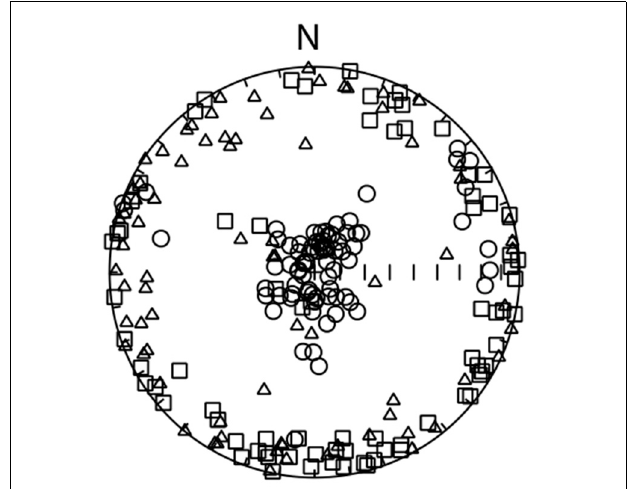
FIGURE 6 | Equal area net showing Moenave Formation high field anisotropy results in stratigraphic coordinates. Open circles are minimum axes, squares are maximum axes, and triangles are intermediate axes, all points lower hemisphere. Minimum axes are perpendicular to bedding, with maximum (and intermediate) axes lying in the bedding plane indicating a bedding parallel fabric typical of deposition and compaction in sedimentary rocks.